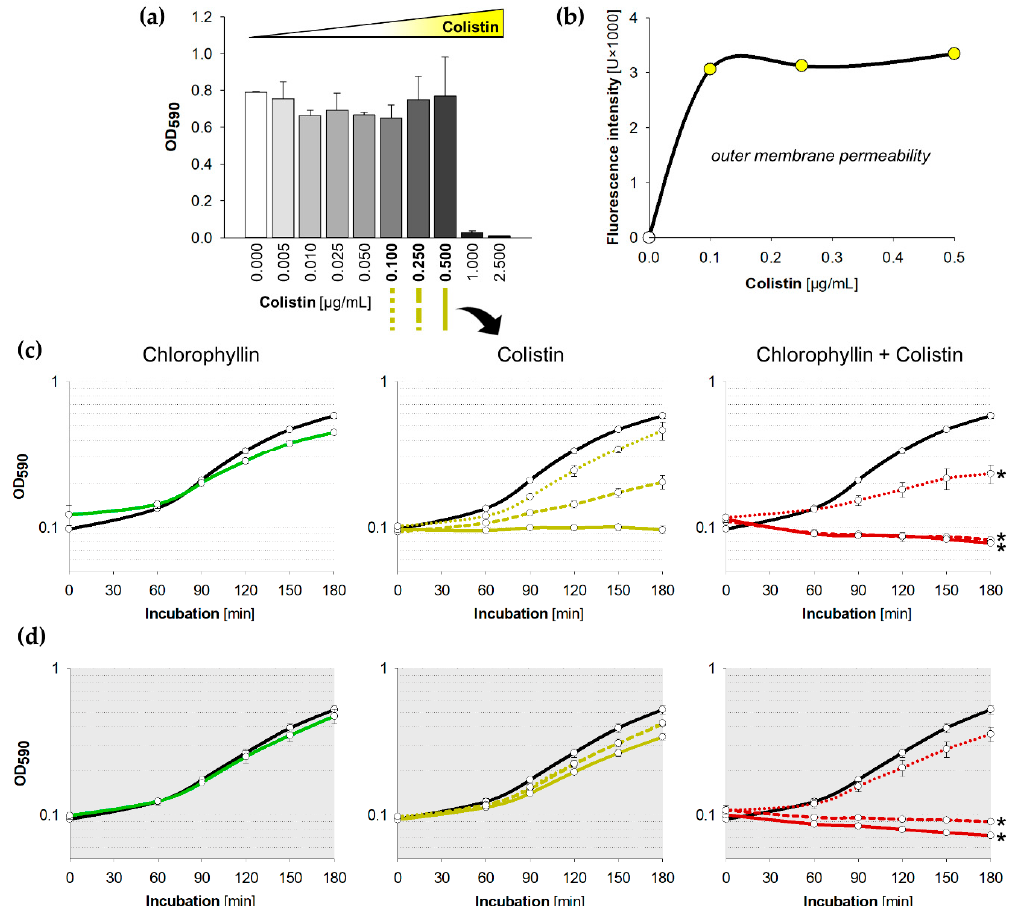
Figure 2. Influence of colistin and chlorophyllin on the growth of Escherichia coli DH5 α ; ( a ) Growth status of E. coli cultures in lysogeny broth (LB) supplemented with different colistin concentrations after 24 h incubation at 37 °C; ( b ) outer membrane permeability of E. coli in the presence of different colistin concentrations determined by using the NPN uptake assay; ( c , d ) Growth pattern of E. coli in the presence of 10 mg/L chlorophyllin (green line, first column), colistin (yellow lines, central column) and of a combination of both substances (red lines, right column). The black lines describe growth in LB without any supplementation; ( c ) cells were illuminated with a light intensity of 12 mW/cm 2 ; ( d ) cells were incubated in dark. In columns two and three, dotted lines describe growth pattern of cultures in LB + 0.10 µg/mL colistin, dashed lines growth pattern of cultures in LB + 0.25 µg/mL colistin, and solid lines growth pattern of cultures in LB + 0.5 µg/mL colistin. Depicted are measured values (circles) and fitted curves (lines) ± standard deviations (n = 3) showing one representative of three independent experiments. *: p < 0.05 vs. chlorophyllin-free samples.